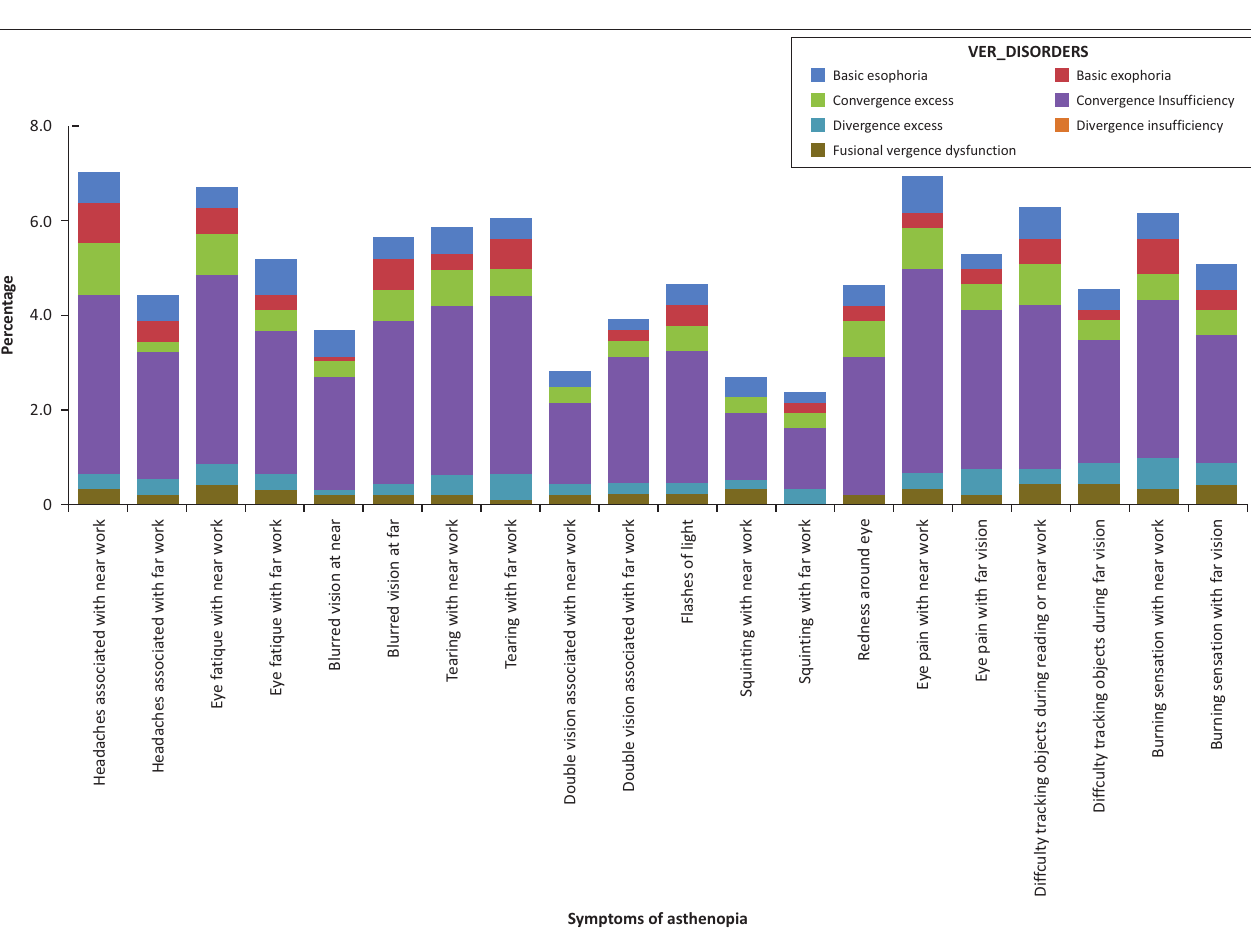
FIGURE 3: Distribution of vergence disorders among specific asthenopic symptoms. TABLE 2: Association between specific symptomatic vergence disorders and asthenopia in univariate analysis. Symptoms Basic esophoria Basic exophoria Convergence